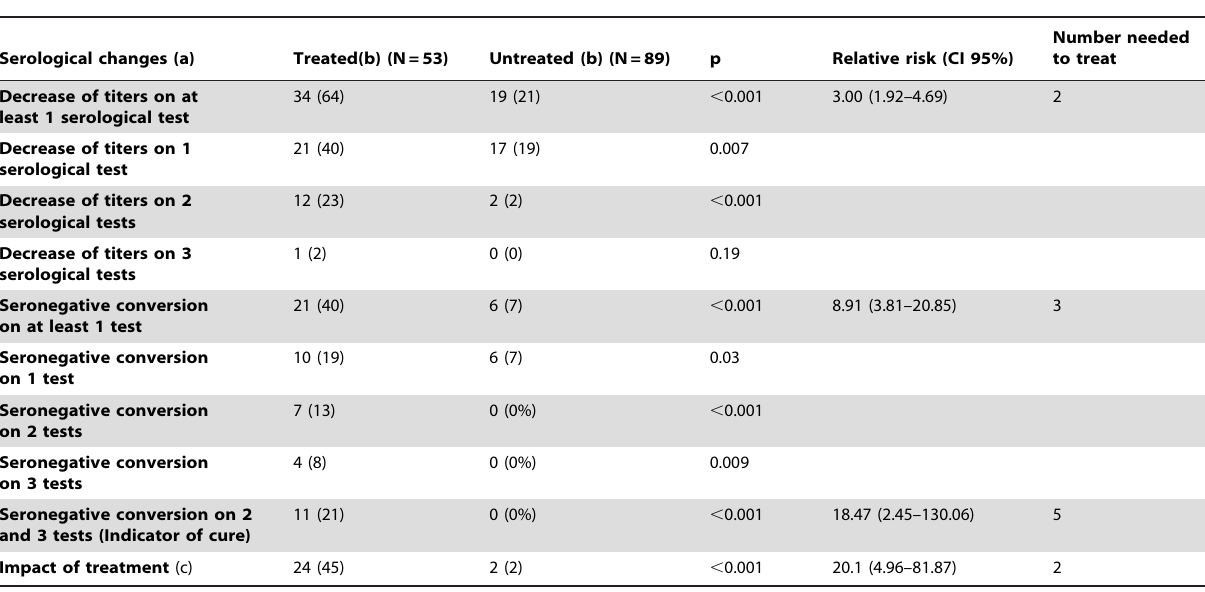
Table 1. Impact of treatment with benznidazole on conventional serology in chronic Chagas disease.